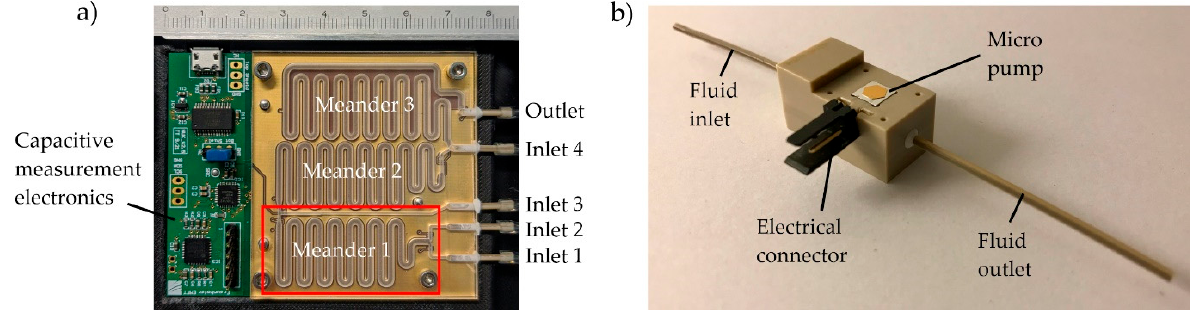
Figure 1. ( a ) Microfluidic channel structure and capacitive sensing electronics. The meander channels have a quadratic cross section of 1.5 × 1.5 mm², and the inlet supply channels have a rectangular cross section of 0.7 × 1.5 mm². The first of three meanders, which is examined in the following experiments, is marked with a red rectangle. ( b ) Fraunhofer EMFT silicon micro pump in a test housing adapter (pump dimensions: 5 mm × 5 mm × 1 mm). housing adapter (pump dimensions: 5 mm × 5 mm × 1